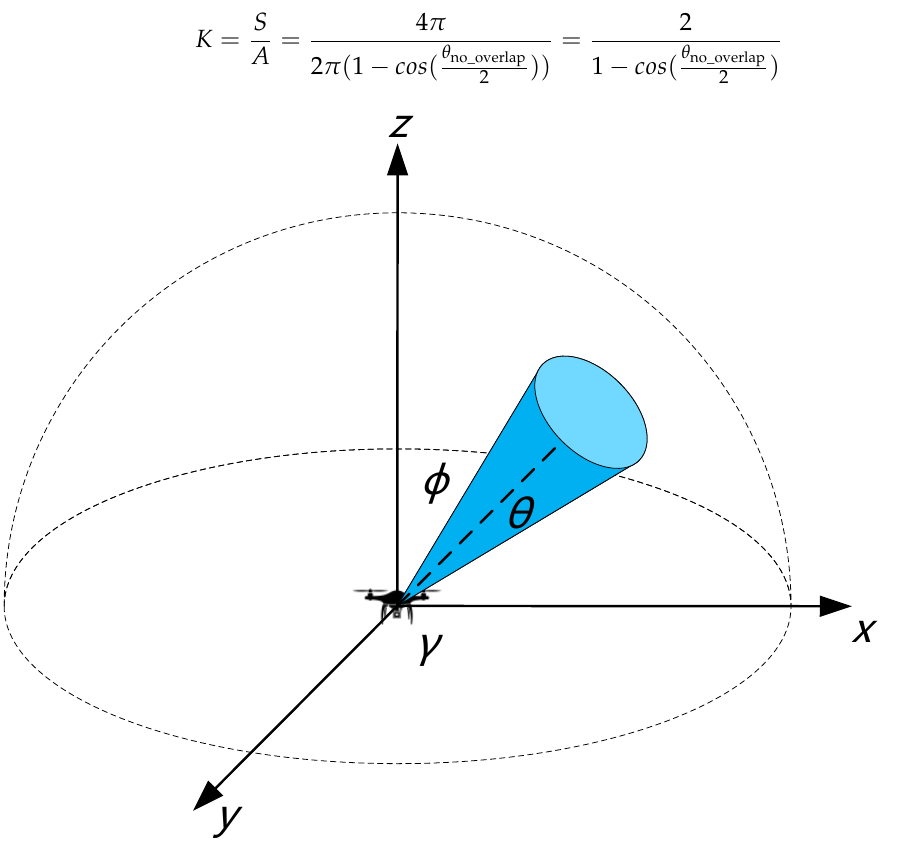
Figure 2. The 3D model of the direction